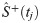
Blood sample data from animal RQ5427 [13].(a) The total numbers of sampled granulocytes (blue triangles), EGFP+ granulocytes (green squares), and the subset of EGFP+ granulocytes that were properly tagged and quantifiable were extracted for PCR amplification and analysis (black circles). This last population defined by S^+(tj) is used to normalize clone cell counts. We excluded the first sample at month 2 in our subsequent analysis so, for example, the sample at month 56 is labeled the 7th sample. There were 536 clones detected at least once across the eight samples taken over 67 months comprising an average fraction 0.052 of all granulocytes. The abundances of granulocyte clones are shown in (b). The relative abundance f^i(tj) of granulocytes from the ith clone measured at month tj is indicated by the vertical distances between two adjacent curves. The relative abundances of individual clones feature large fluctuations over time. “Extinctions” followed by subsequent “resurrections,” were constantly seen in certain clones as indicated by the black circles in (b) and in the inset (c).